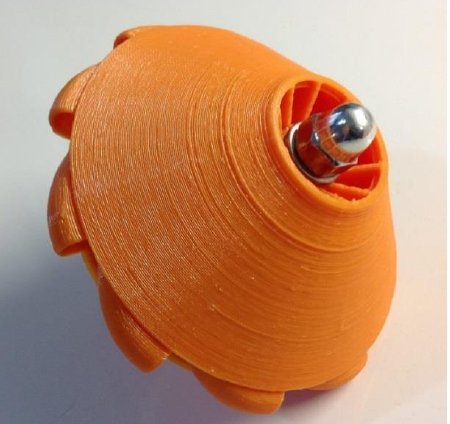
Figure 3. Micromodel of Euler turbine (rotor version). Source: authors’ development.